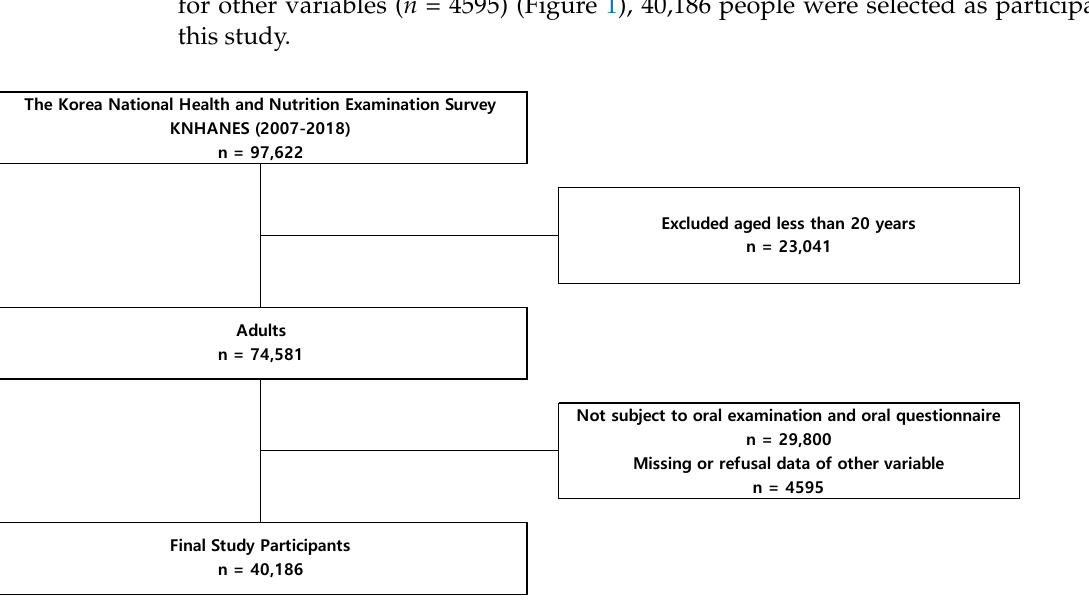
Figure 1. Schematic diagram of study participants.